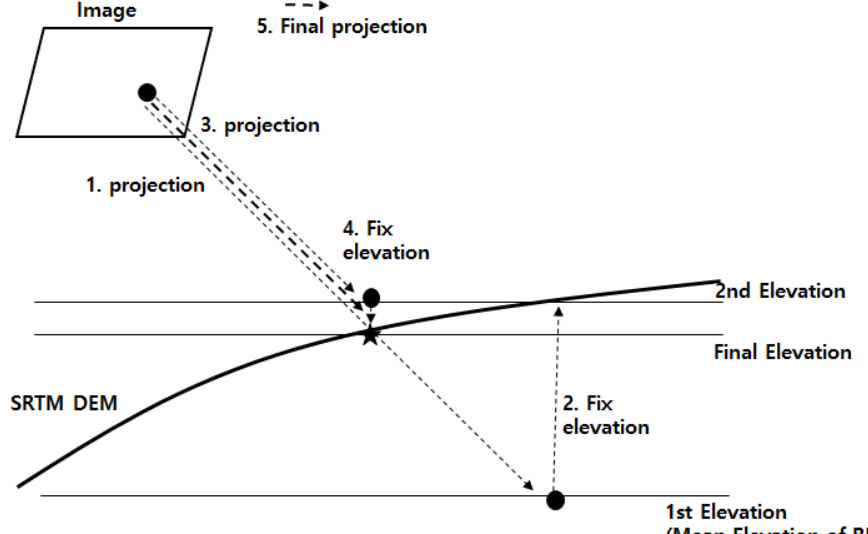
Figure 3. Iterative ground elevation search.